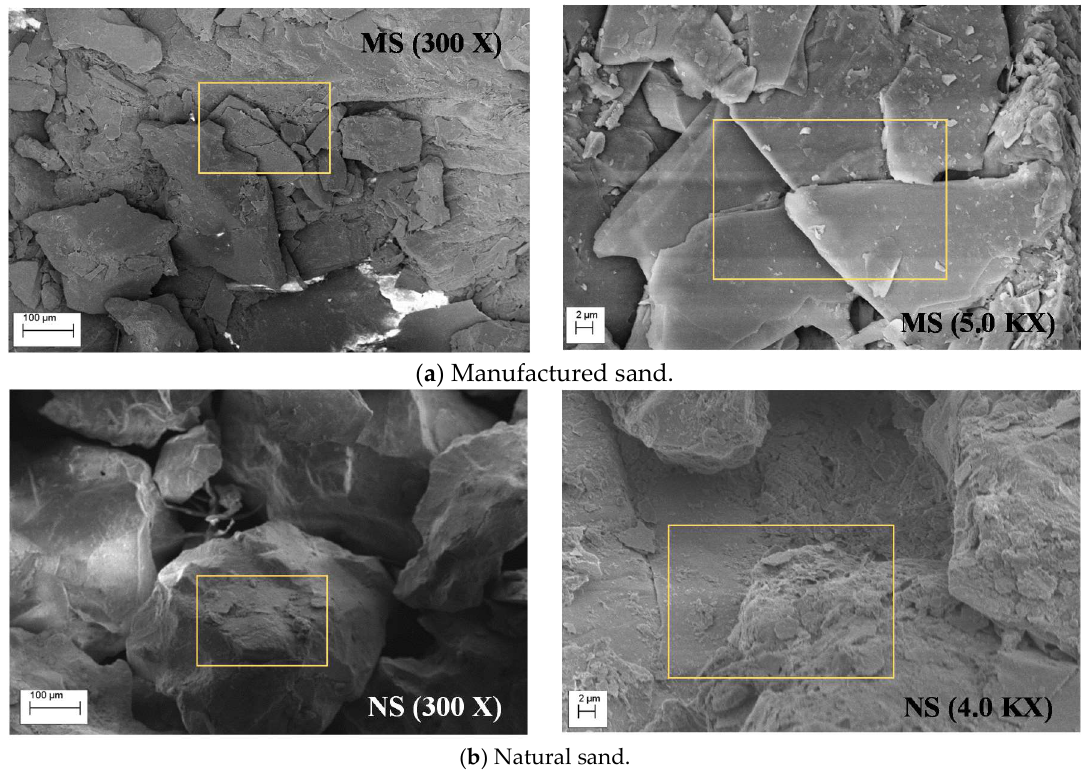
Figure 7. SEM images of fine aggregates (note: 1 KX = 1000 X).